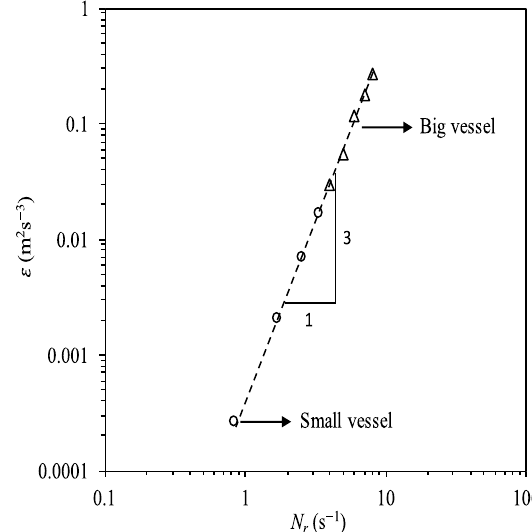
Figure 3. The value of ε obtained using Equation (11). Its value was calculated based on the measured torque. A highly sensitive torque meter equipped with a rotary viscometer (Model LV,